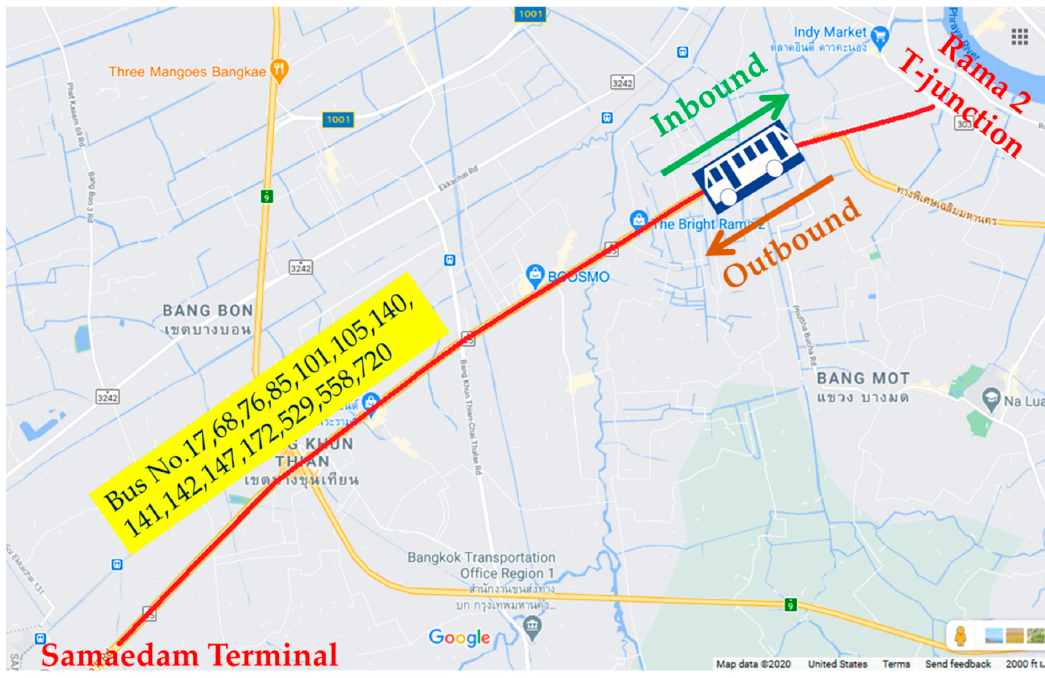
Figure 1. Bus Network before Reform (Adapted from Google Map).